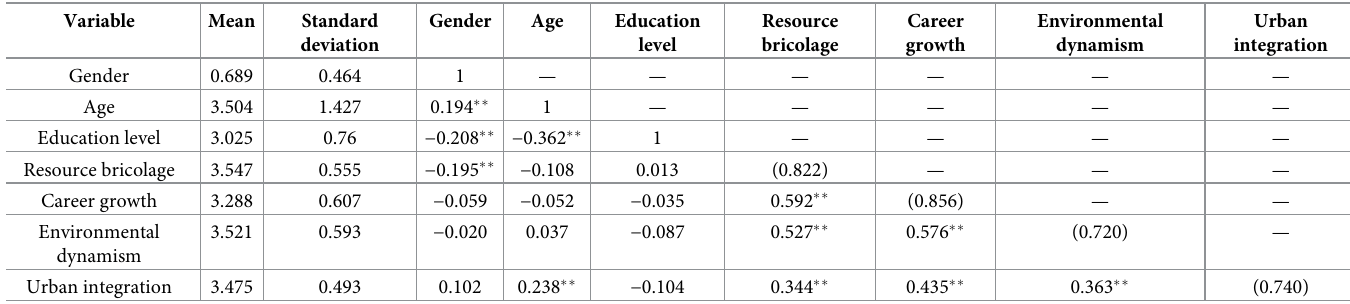
Table 2. Means, standard deviations, and correlation matrix.